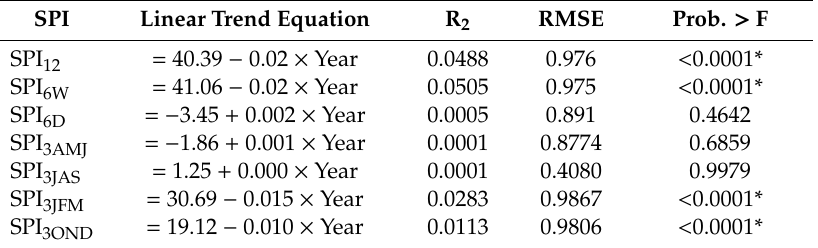
Table 4. Linear trend analysis for standardized precipitation index over